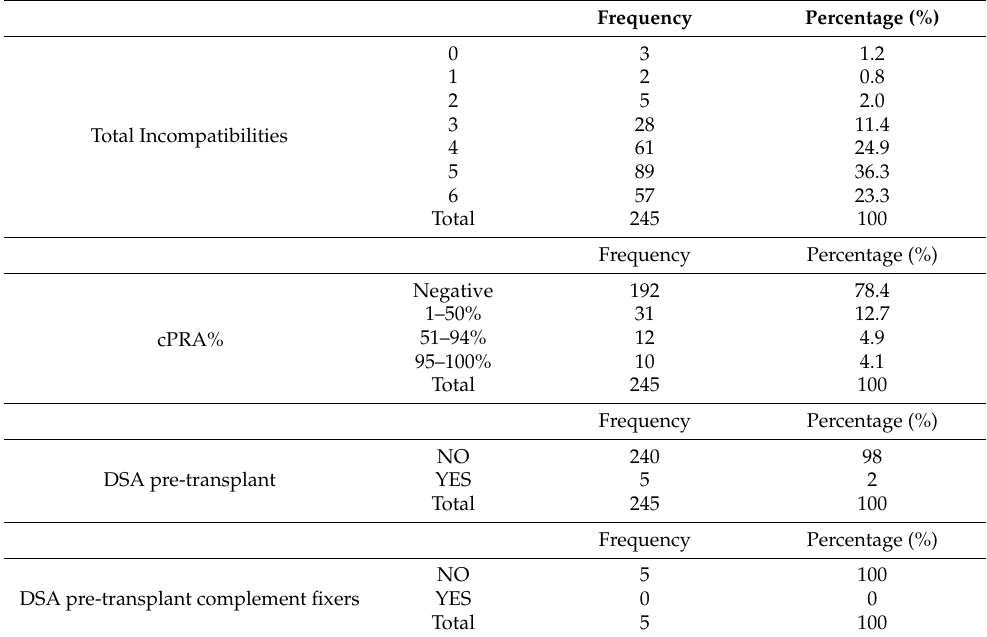
Table 1. Description of variables pre-renal transplantation.